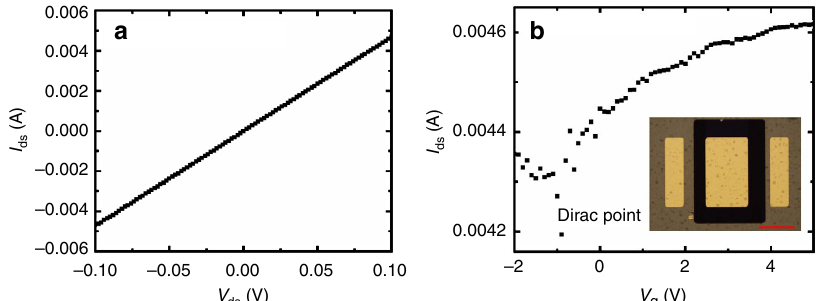
Figure 4 | Top gate field-effect transistor fabricated on graphene on diamond. ( a ) Two terminal current–voltage characteristics I ds versus V ds at zero gate bias. ( b ) Three-terminal measurement source-drain current versus top-gate bias. Drain voltage is fixed at 0.1V. Scale bar, 100 m m. The dark part is a dielectric layer of HfO 2 with the size of 200 m m by 300 m m. The gate electrode is 200 m m in width and 120 m m in length. The source and drain electrodes are 200 m m in width and 50 m m in